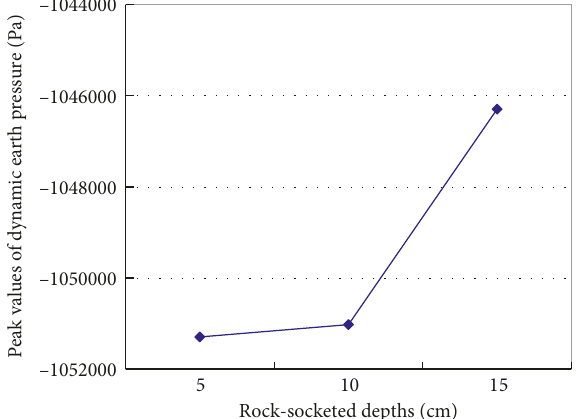
Figure 13: Peak values of dynamic Earth pressure under different rock-socketed depths.